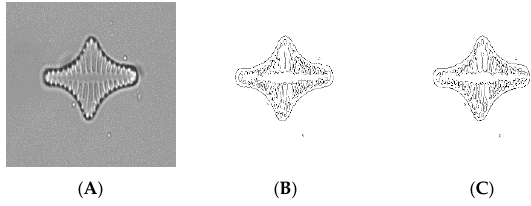
Figure 6. Optimal Canny segmentation; ( A ) Original images; ( B ) PST results; ( C ) Manual results obtained by an expert. Table 1. Segmentation results.